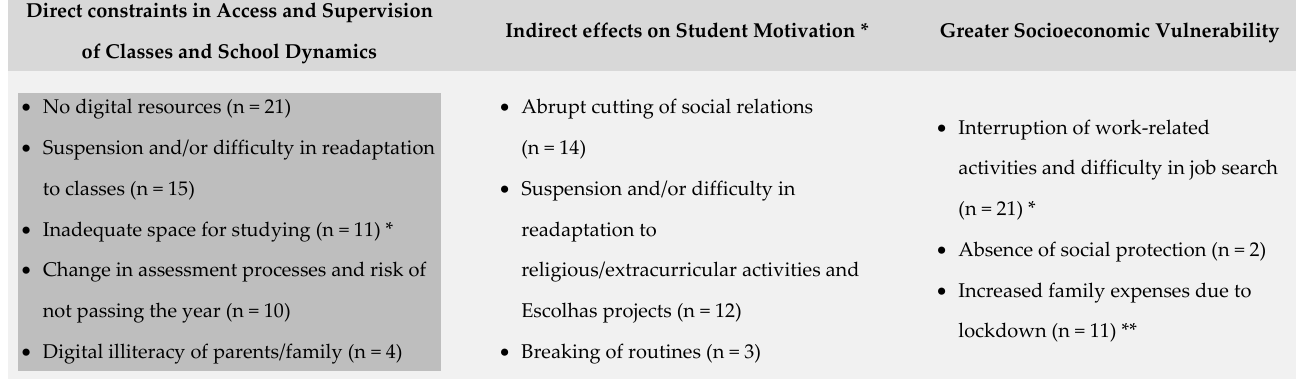
Figure 2. Perception of the different-role participants about the impacts of the pandemic on educational pathways. Note: * Emphasized only by Ciganos/Roma Youngsters and Families/Activists. ** Emphasized only by Technical Staff of the Escolhas Projects.